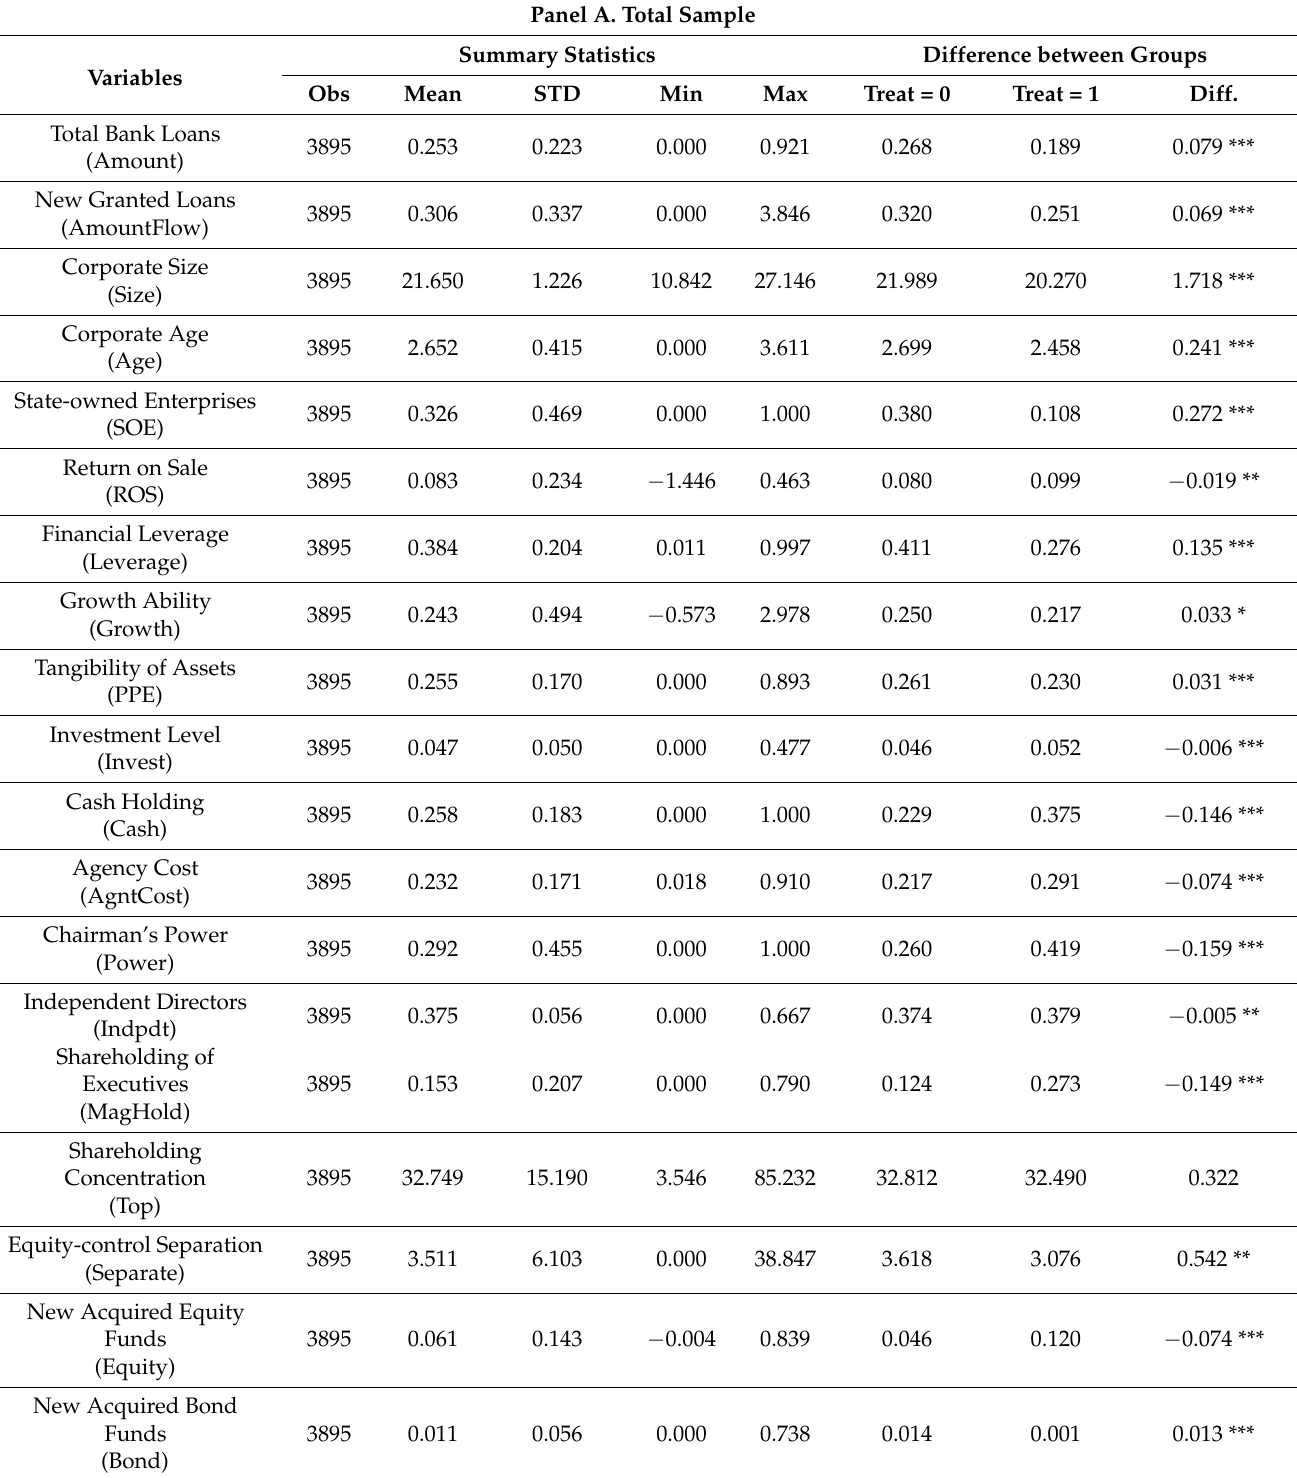
Table 1. Summary